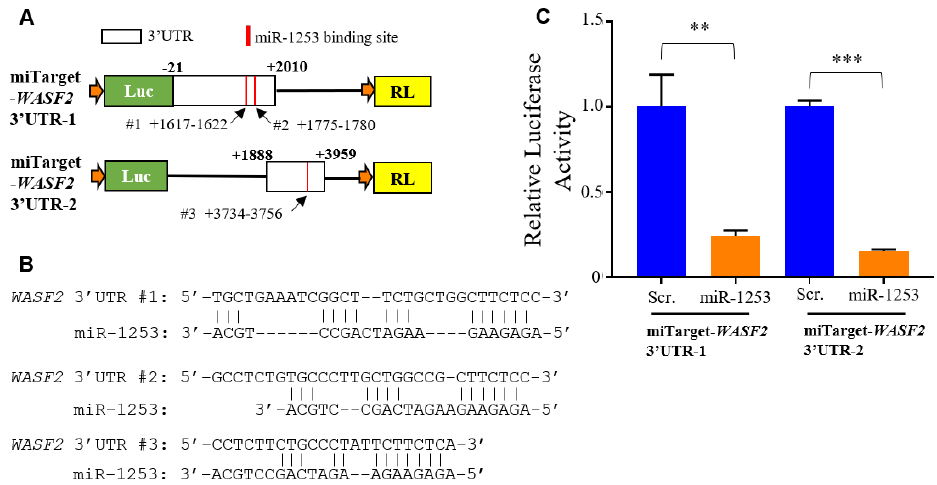
Figure 3. miR-1253 targeting of the WASF2 3′ UTR. ( A ) Schematic of the miRTarget WASF2 3′ UTR vectors (plasmid 1 and 2). The predicted binding sites of miR-1253 to the WASF2 3′ UTR are indicated in red with designated base pair positions. ( B ) Base pair schematic of binding site #3 of miR-1253 to the 3′ UTR region of WASF2 , as predicted by TargetScan. ( C ) The relative expression of luciferase (Luc) reporter in the presence of 50 nM miR-1253 for 48 h and compared with scrambled control. Data were normalized to an internal renilla control and normalized to 1.0. ** p < 0.01; *** p < 0.001, by two- tailed student’s T-test.